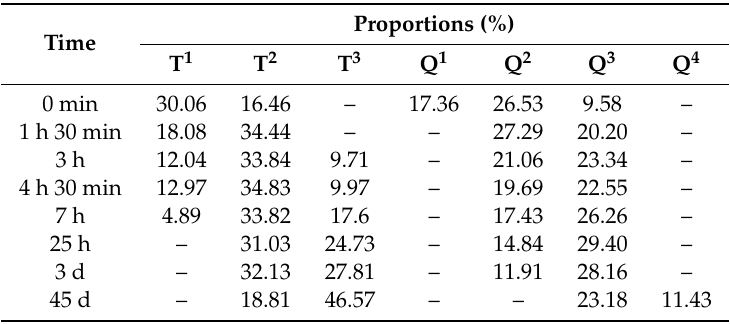
Deconvolution of 29 Si NMR spectra for polysiloxane hybrids synthesized from the [TMOS] / [MPTS] mixture at room temperature (RT) for di ff erent times.